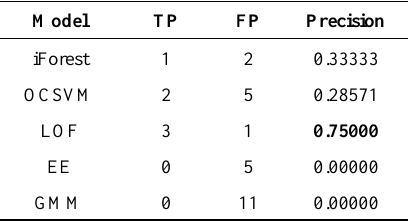
Table 5. Percentage error obtained for machine temperature system failure from NAB dataset.